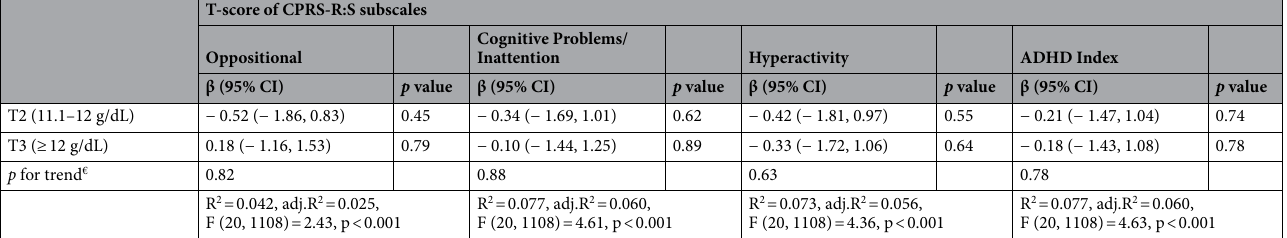
Table 2. Unadjusted and multivariate-adjusted linear regression models of the associations between maternal SF and Hb levels (continuous, tertiles) and children’s T-score of CPRS-R:S subscales at age 7 years. CI confidence interval, SD standard deviation, BMI body mass index, T tertile, SF serum ferritin, Hb haemoglobin, CPRS-R:S Conners’ Parent Rating Scale-Revised Short Form, ADHD attention deficit hyperactivity disorder. Linear regression models were used to calculate β coefficient (β) and 95% confidence intervals (CIs). Bold values denote a significant statistical test at a level of statistical significance p-value < 0.05. †Models were adjusted for cohorts (Gipuzkoa, Sabadell, Valencia), maternal age (years), maternal pre- pregnancy BMI (kg/m 2 ), social class (low, medium, high), smoking during pregnancy (yes, no), mode of delivery (eutocic, dystocic), parity (primiparous, multiparous) breastfeeding (months), total iron intake above the RDA (27 mg/d) (yes, no), children’s sex (male, female), age at delivery (weeks), birth weight (kg), birth head circumference (cm), children’s age at time of test (years) and BMI-for-age z-score at age 7 years, log-SF levels in 1st period (μg/L) (for Hb analyses) and Hb levels (for SF analyses). € Tests for trend were conducted using the median values for each tertile of SF or Hb as a continuous variable in the multivariate regression models. *SF measurements at first and second trimester as a whole were defined as first period of pregnancy.